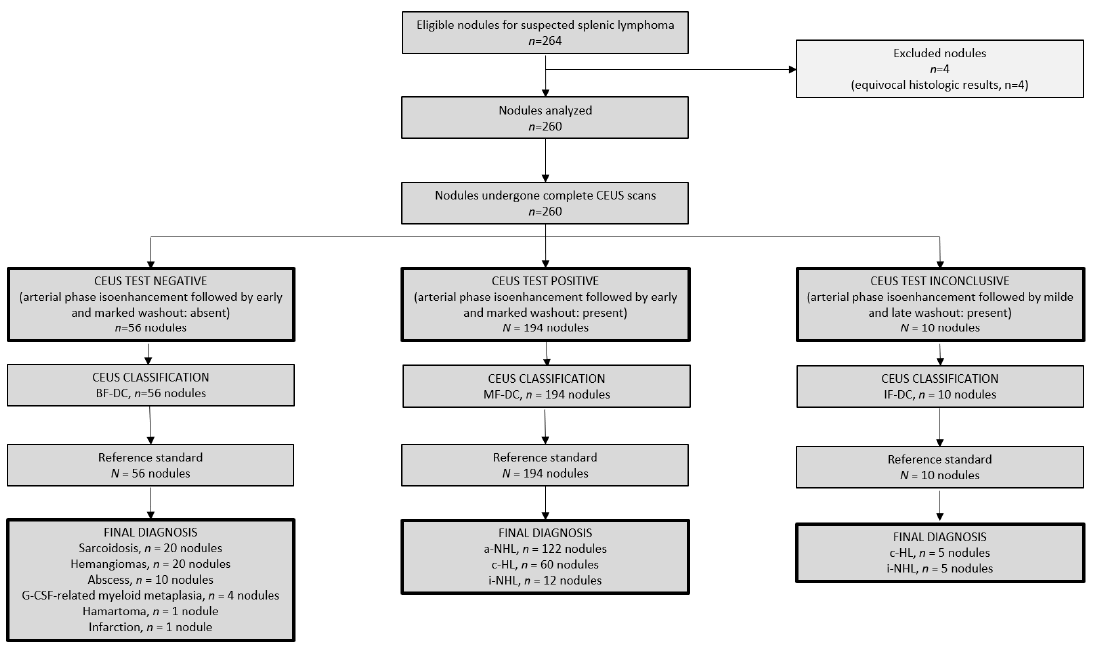
Figure 1. Consort diagram. The flow of nodules through the study. CEUS, contrast-enhanced ultra- sonography; BF-DC, benign findings-diagnostic criteria; MF-DC, malignant findings-diagnostic cri- teria; IF-DC, inconclusive findings-diagnostic criteria; G-CSF, granulocyte-colony stimulating fac- tor; a-NHL, aggressive non-Hodgkin lymphoma; c-HL, classic Hodgkin lymphoma; i-NHL, indo- lent non-Hodgkin lymphoma. a-NHL included diffuse large B-cell lymphomas ( n = 108 nodules), T- rich B cell lymphomas ( n = 10 nodules) and anaplastic T-cell lymphoma ( n = 4 nodules). c-HL in- cluded nodular sclerosis ( n = 50 nodules), mixed cellularity ( n = 11 nodules) and lymphocyte-rich ( n = 4 nodules) subtypes. i-NHL included grade 1–2 follicular lymphoma ( n = 17 nodules). Patient and splenic nodule characteristics are reported in Table 1. Table 1. Patient and splenic nodules characteristics.